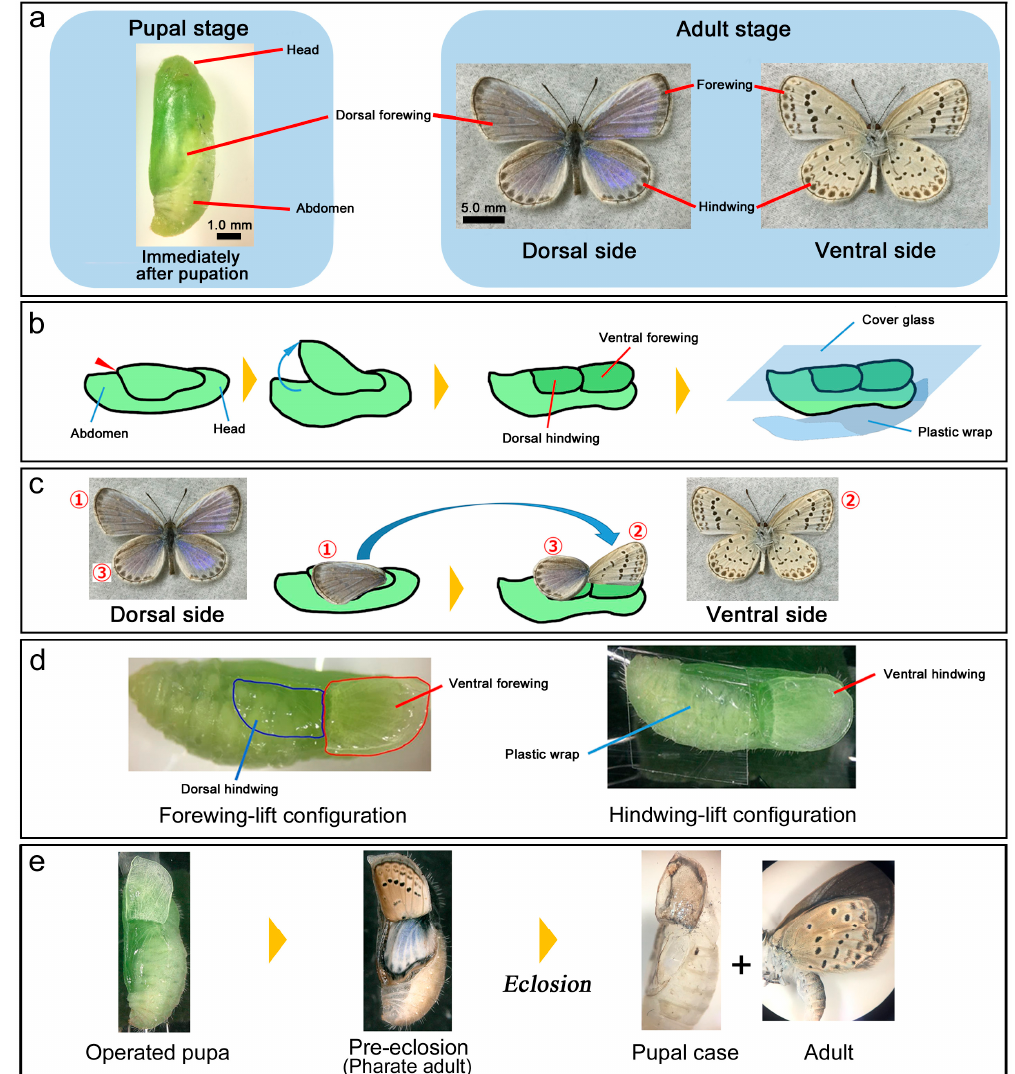
Figure 2. Surgical procedures used in this study. Also see Figure B; Video S1. ( a ) Pupal and adult morphology. Wings are located on the surface of the pupal body. Hindwings are not seen because they are placed underneath the forewings. Immediately before eclosion, adult forewing color patterns can be seen through the pupal cuticle. ( b ) Forewing-lift operation. The margin of the dorsal forewing is lifted slowly until the ventral forewing and dorsal hindwing can make a single plane. A piece of cover glass is then placed onto these wings. The pupal body is covered and fixed with a piece of plastic wrap from underneath the body. ( c ) Correspondence between the operated pupal wings and adult wings before and after the forewing-lift configuration indicated by numbers. ( d ) A pupa of the forewing-lift configuration (left) and a pupa of the hindwing-lift configuration (right). ( e ) Rough time course of